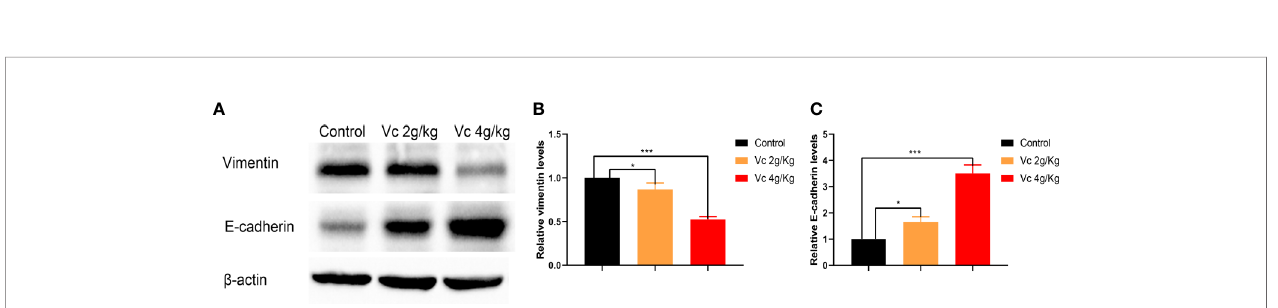
FIGURE 3 | Vitamin C disrupts ascites-derived multicellular spheroid and prevents multicellular spheroid formation in vitro . (A) Representative images of ascites- derived multicellular spheroids in 6-well plate. upper panels ×40 and lower panels ×100. (B) The quantitation of ascites-derived multicellular spheroids in 6-well plate. Data are mean ± SEM; n=5. ***p < 0.001. (C) Representative images of multicellular spheroids constructed in vitro by mixed ID8 cells and macrophages. upper panels ×40 and lower panels ×100. (D) The quantitation of multicellular spheroids constructed in vitro by mixed ID8 cells and macrophages. Data are mean ± SEM; n=5. ***p. < 0.001.